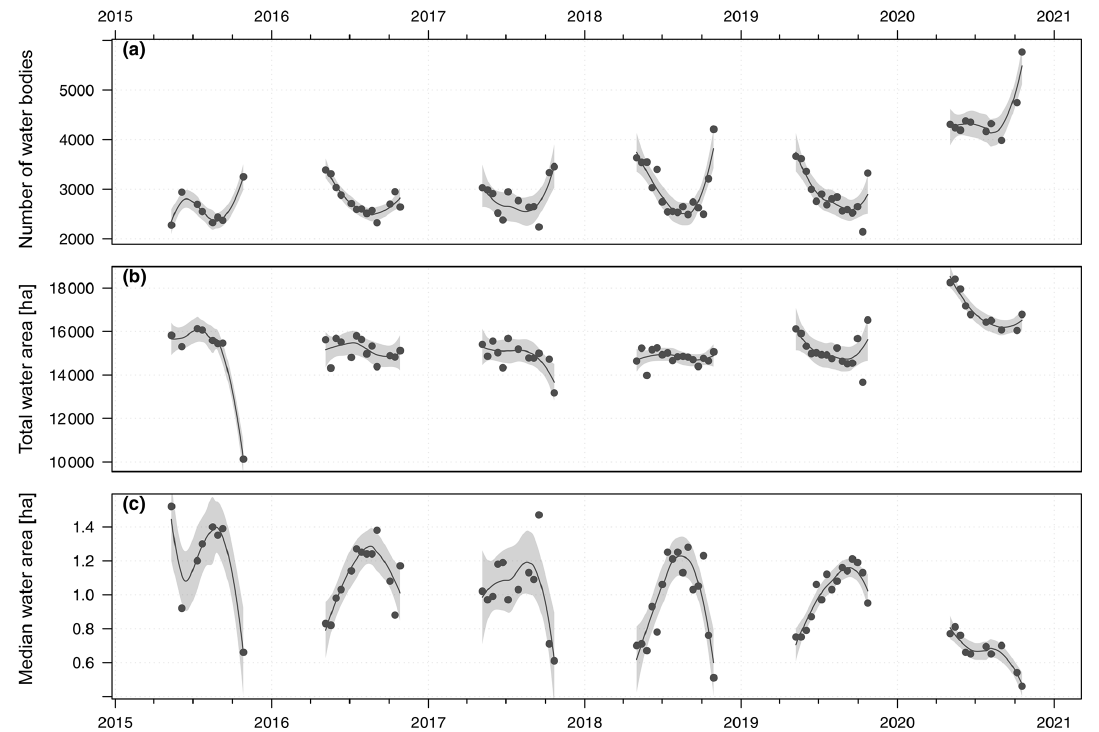
Figure 8. (a) Number of waterbodies, (b) total water area and (c) median waterbody size across the Pipestem Creek basin for each of the Sentinel-1 scenes. Lines show LOESS smoothing functions along with 95% confidence